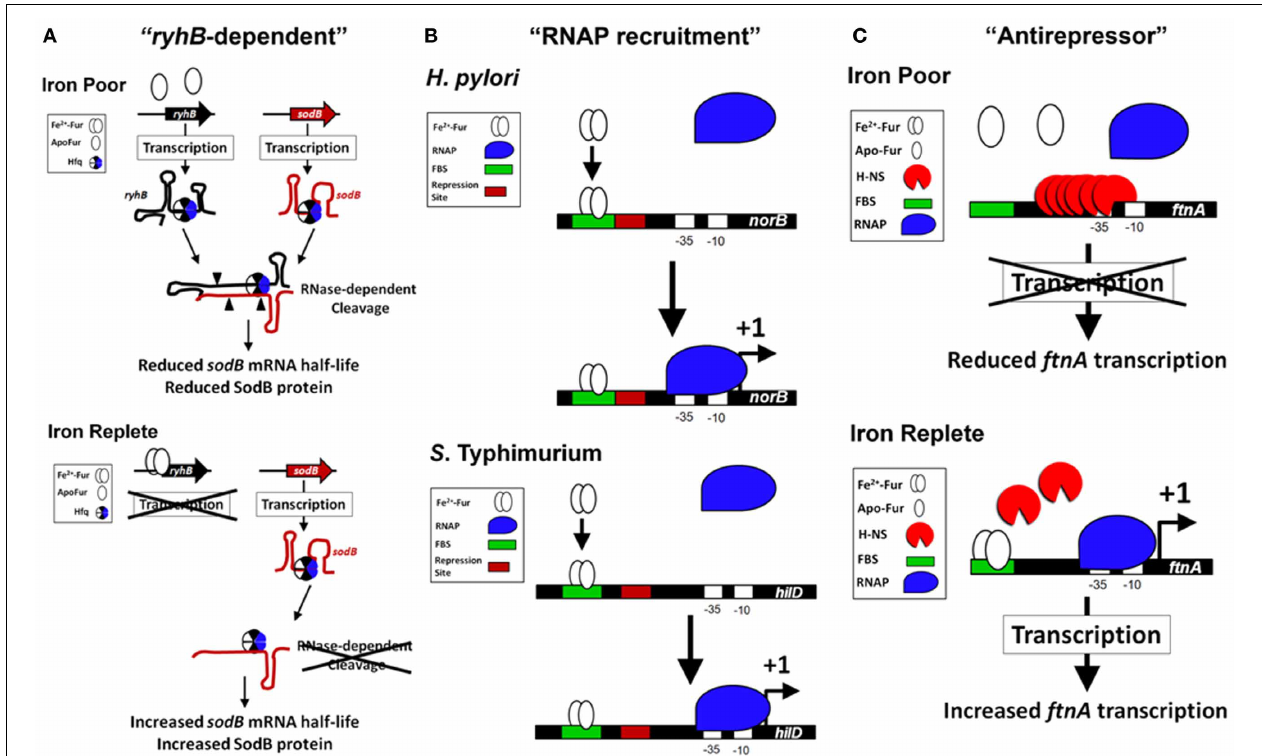
FIGURE 2 | Models of the Fur-dependent activation of gene expression in bacteria. (A) Fur activation through “ ryhB -dependent” mechanism (SodB as an example). Fur is indirectly required for the expression of the FeSOD (SodB) in bacteria through the sRNA ryhB (Masse and Gottesman, 2002; Ellermeier and Slauch, 2008). Under conditions of Fe 2 + depletion (top panel), Fur is unable to directly repress transcription of the sRNA ryhB (or its paralog). This results in an increase in the level of ryhB within the cell. The RNA chaperone Hfq binds to ryhB and to the target mRNA of sodB (Afonyushkin et al., 2005; Urban and Vogel, 2007), which through the RNase-dependent cleavage (cleavage sites are signified by filled triangles) reduces the half-life of sodB mRNA and reduces SodB protein within the cell. The Fur activation of sodB is diminished in the absence of Hfq or ryhB (Masse and Gottesman, 2002; Ellermeier and Slauch, 2008; Troxell et al., 2011a). When Fur is activated during Fe 2 + replete conditions (bottom panel), transcription of ryhB is blocked, which increases the half-life of sodB mRNA allowing for enhanced production of SodB protein and FeSOD activity. (B) Fur activation through “RNAP recruitment” mechanism (Examples from S . Typhimurium and H. Pylori ). In vitro transcription assays